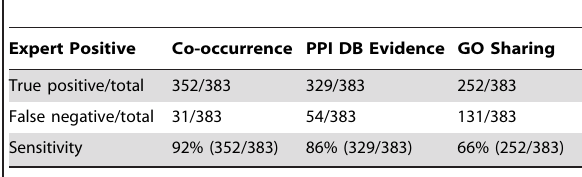
Table 2. PPI Database Evidence Evaluation.